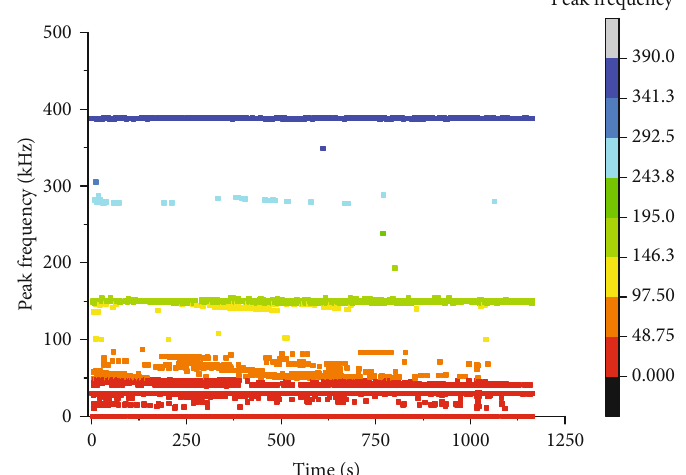
Figure 6: Distribution of peak frequency during tensile test. There are fi ve types of peak frequency signals during the tensile test, which are distributed in fi ve ranges: 0-48 kHz, 50-97 kHz, near 149kHz, around 284 kHz, and near